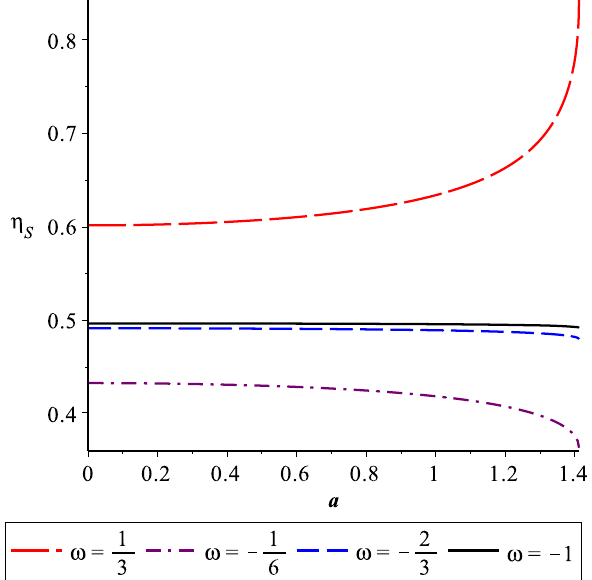
Fig. 12 Efficiency of the black hole as a heat engine in the square cycle, η S , versus the quantum correction, a , for different fluids. Values of the thermodynamic quantities are ˜ S 1 = ˜ S 4 = 2, ˜ S 2 = ˜ S 3 = 4 and P 1 = P 2 = 2 and P 3 = P 4 = 1. We have M 1 > M 2 and M 4 > M